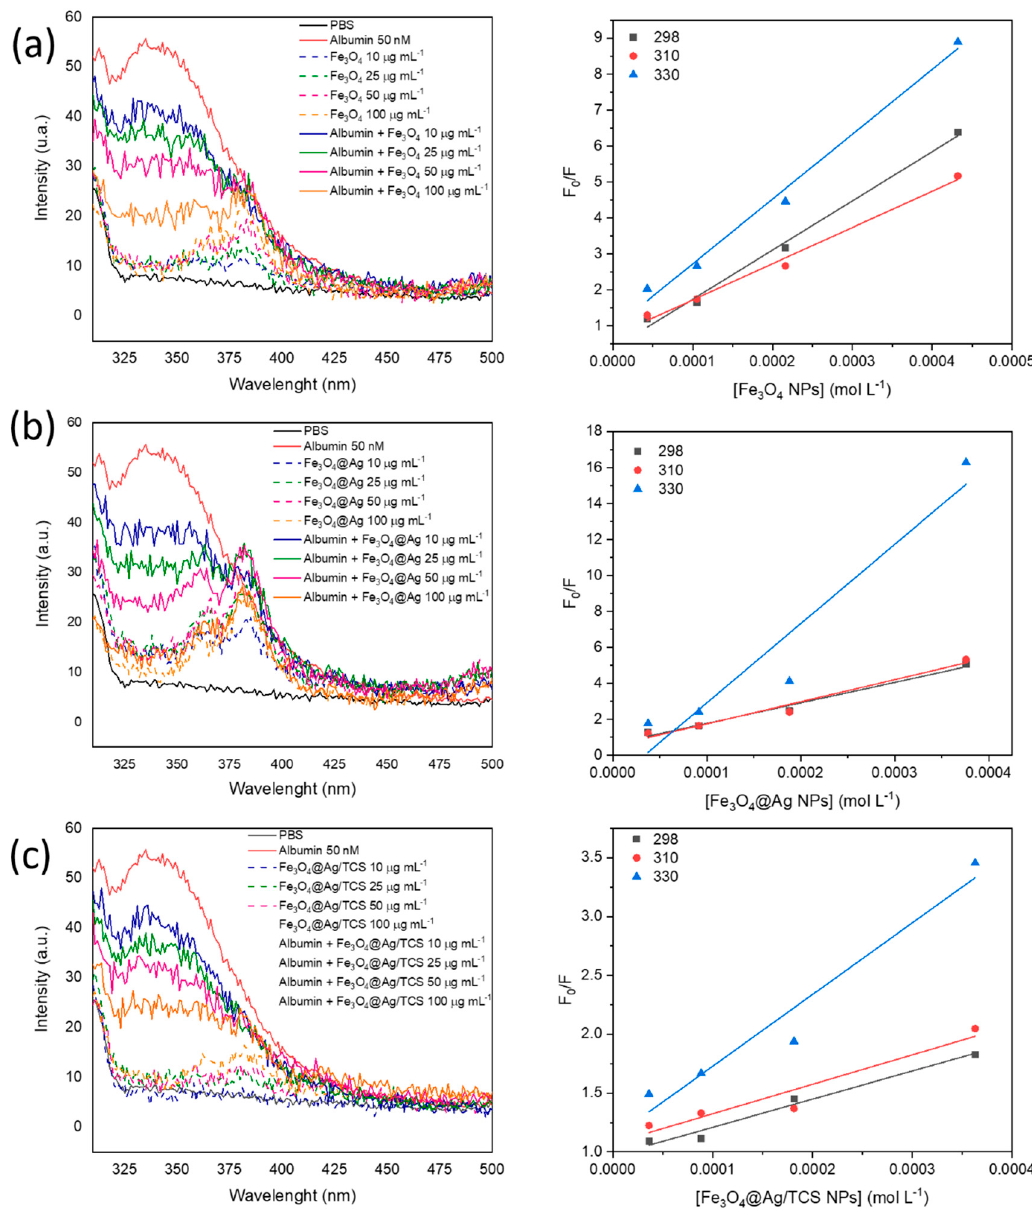
Figure 4. Fluorescence spectra and Stern-Volmer plot of F 0 /F vs. NPs concentration ([NP]) for ( a ) Fe 3 O 4 NP, ( b ) Fe 3 O 4 @Ag, and ( c ) Fe 3 O 4 @Ag/TCS incubated with albumin at 298, 310, and 330 K. The concentrations of NPs were given in mol L − 1 , taking into account the molar mass of magnetite NPs and the proportion of this NP in the other materials (87% in Fe 3 O 4 @Ag and 84% in Fe 3 O 4 @Ag/TCS). Table 2. Parameters estimated for Fe 3 O 4 NPs, Fe 3 O 4 @Ag NPs, and Fe 3 O 4 @Ag/TCS NPs fitted accord- ing to Stern-Volmer equation from Figure 4.